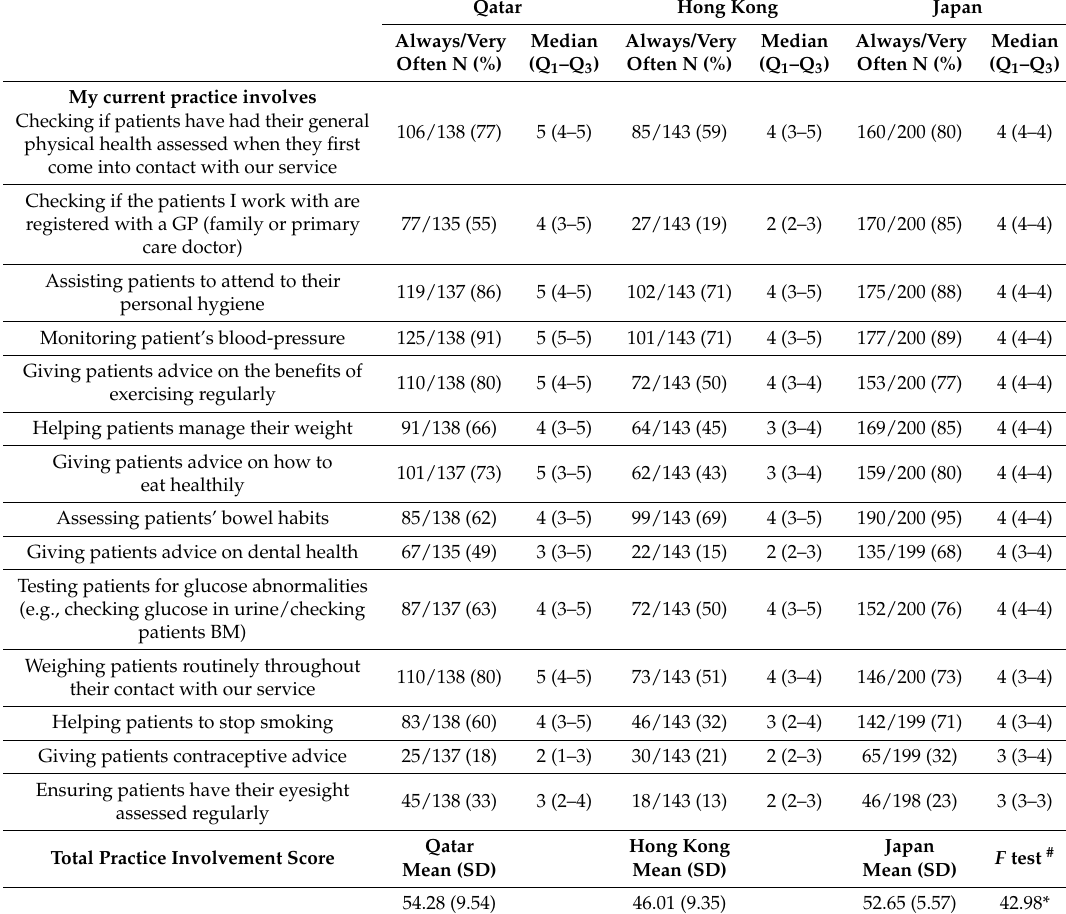
Table 2. Participants’ current practice in physical health care and cross-country